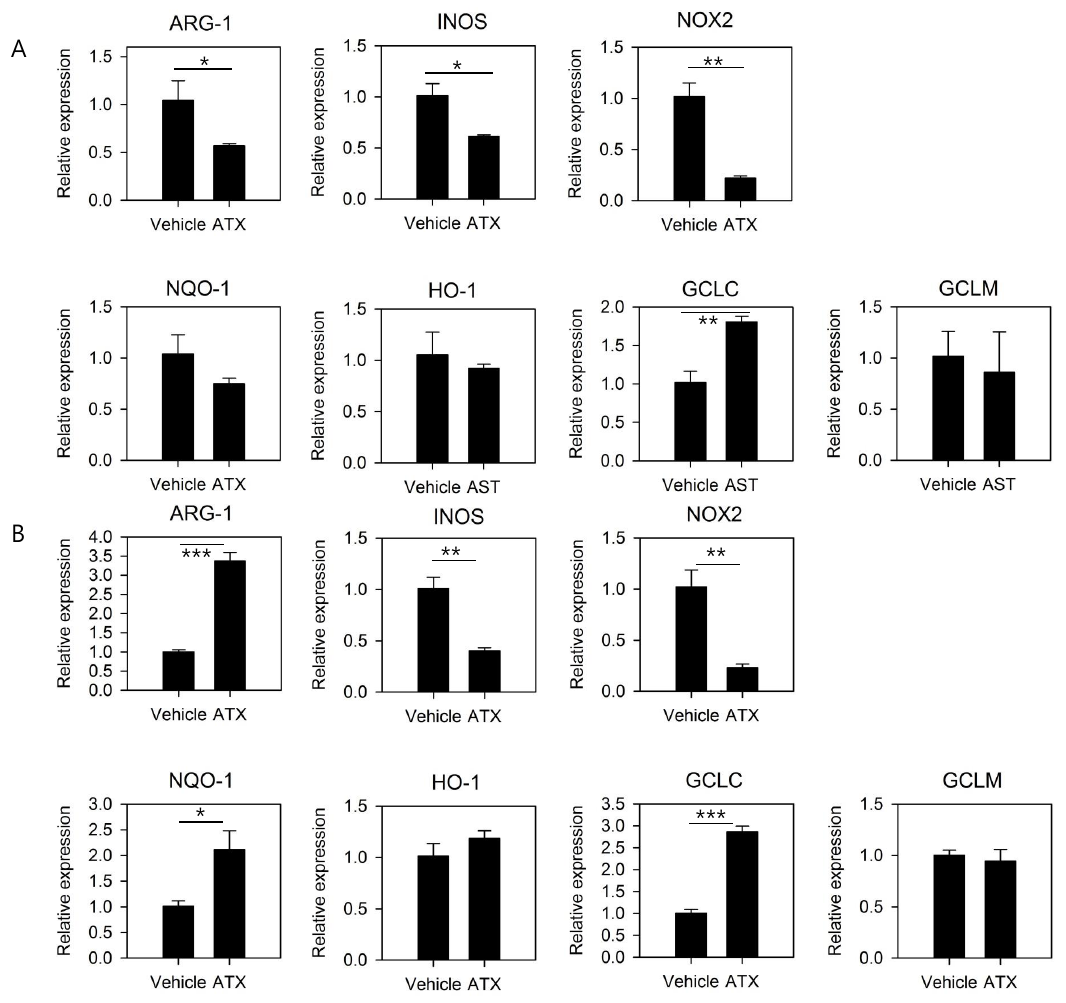
Figure 3. ATX treatment reduces the expression of functional mediators of MDSCs and induces the expression of genes involved in GSH synthesis. MDSCs were isolated from spleens of tumor-bearing mice and cultured for ( A ) 24 h and ( B ) 5 days in the presence of ATX and LPS. RNA was extracted, and expression of the indicated genes was evaluated by the quantitative real-time PCR. Data are presented as means ± SEM of three samples and are representative of at least three experiments. * p < 0.05, ** p < 0.01, *** p <